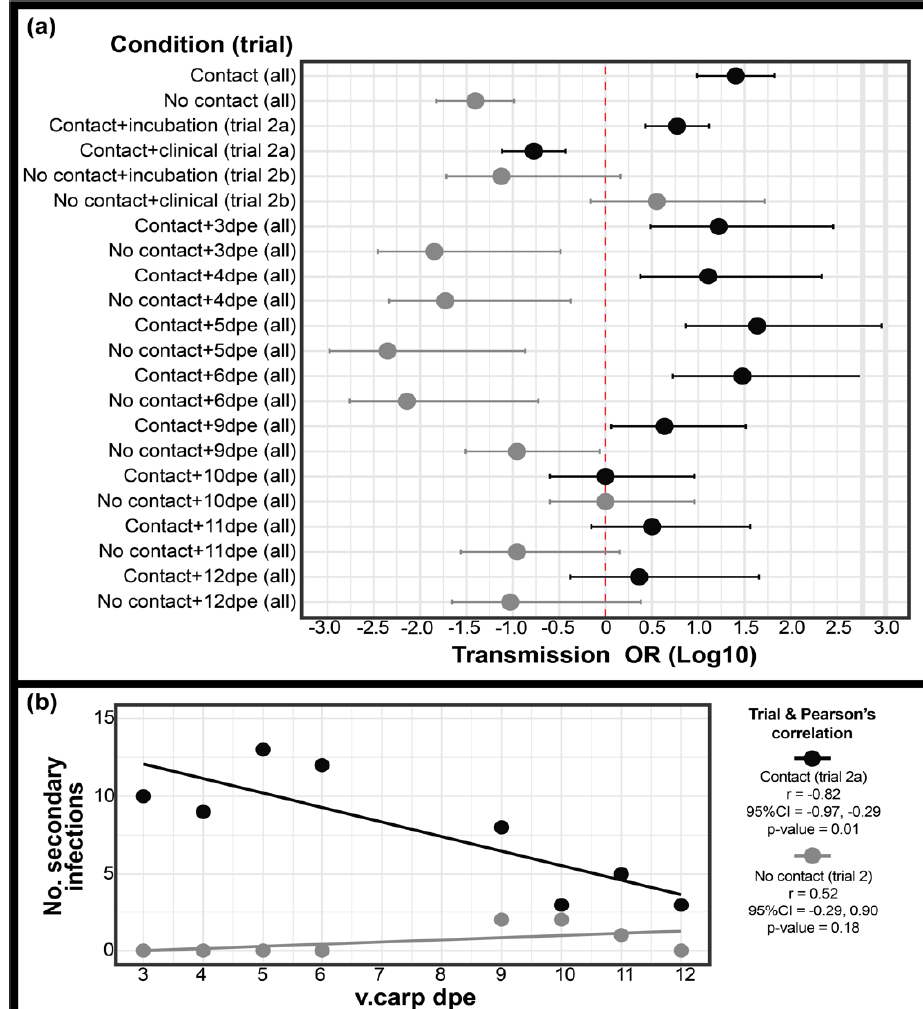
Figure 4. Trial 2 odds of transmission and number of secondary infections. ( a ) forest plot of CyHV-3 transmission odds for contact Trial 2 replicates. Significant ORs are indicated by error error bars that do not cross the center 0 value. “Condition” indicates the contact group (i.e., Trial 2a or 2b) and disease period or experimental replicate for which the OR is calculated. “Trial” indicates which data is considered for comparison and is denoted as“All” (indicates that comparisons are of aggregated data from all other serial experiments) or aggregated Trial 2a or 2b serial experiments only. ( b ) No of secondary infections of s.carp (i.e., transmission) in Trial 2a and 2b.